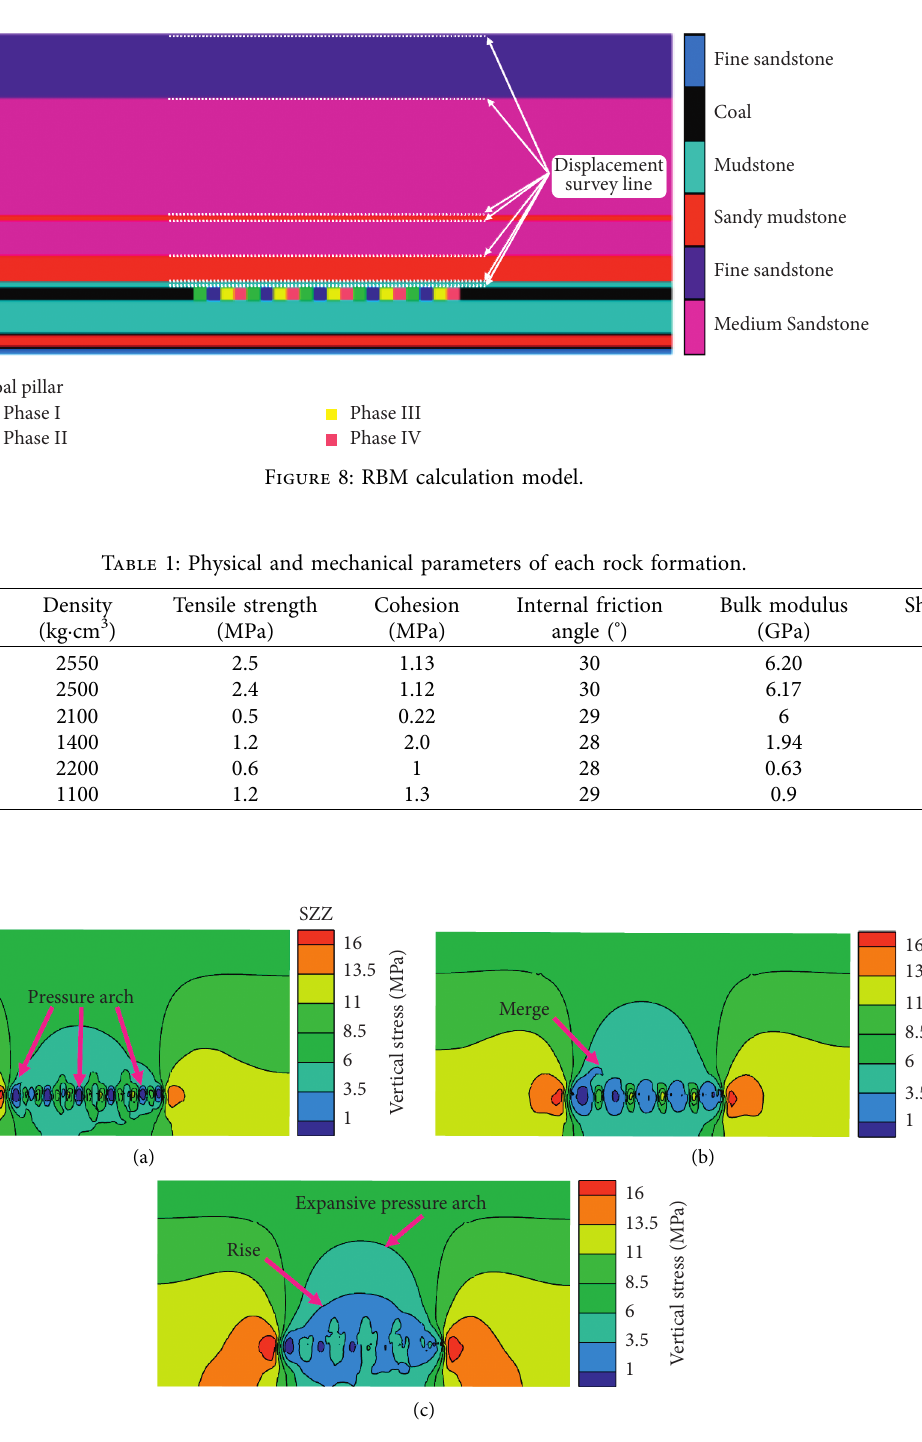
Figure 9: Vertical stress. (a) First stage. (b) Second stage. (c) Third stage.